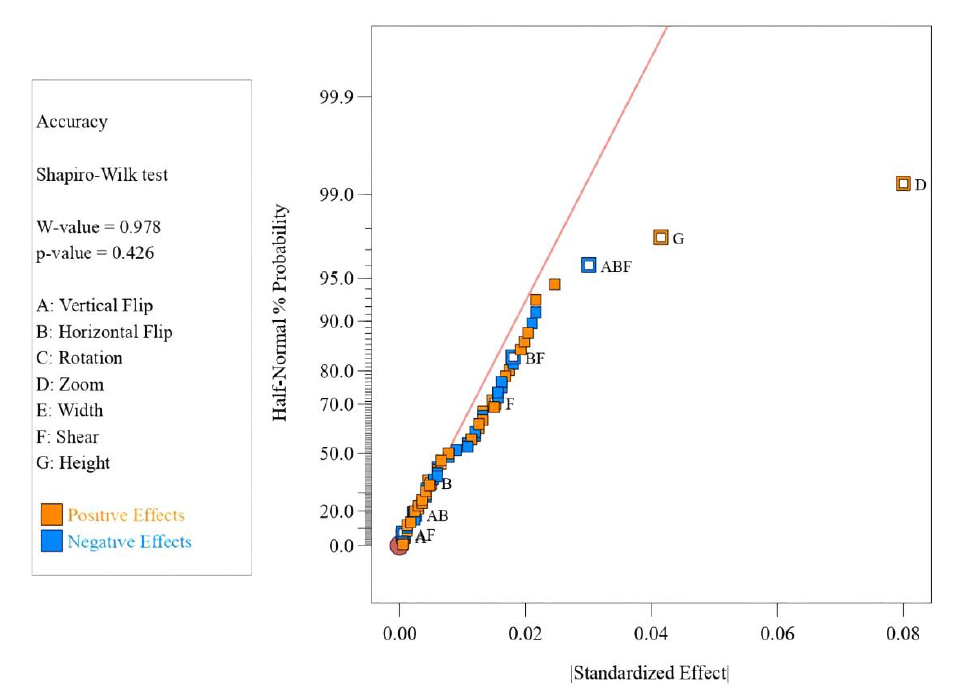
Figure 5. Half Normal Plot for Dataset